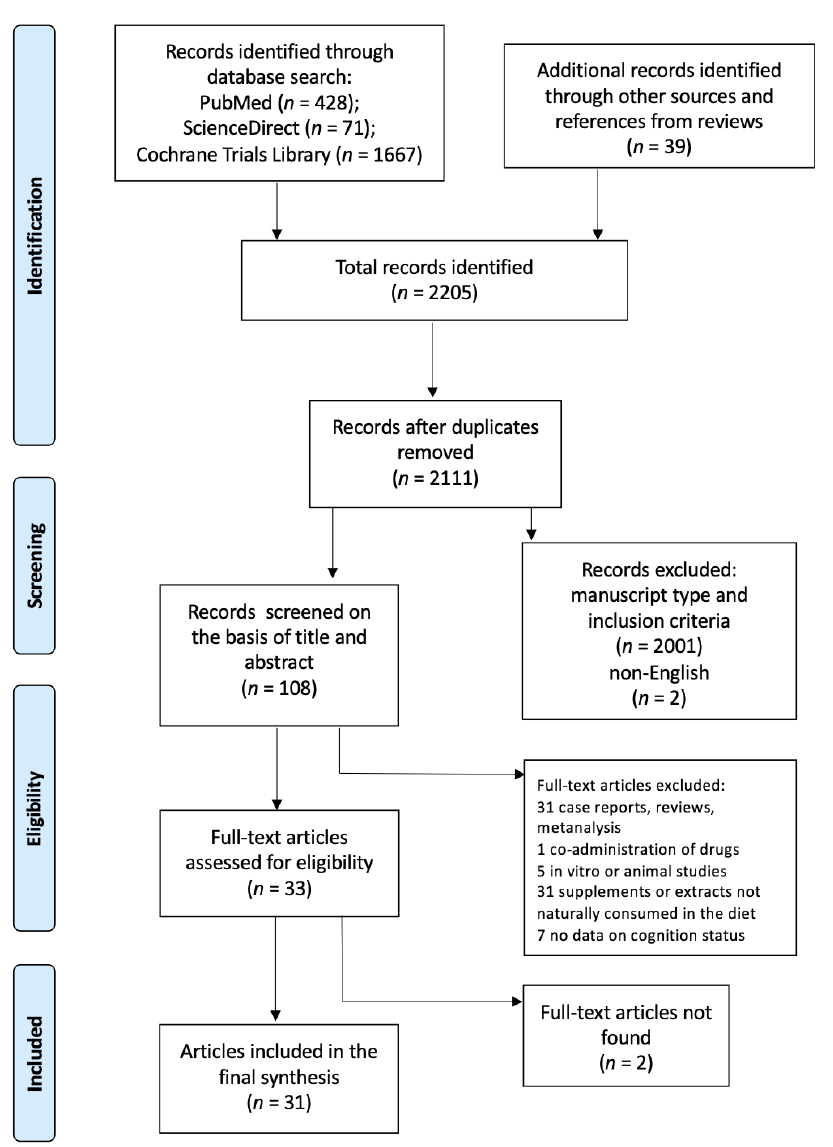
Figure 1. Flow diagram of the search strategy. Adapted from Moher et al., 2009 [68].